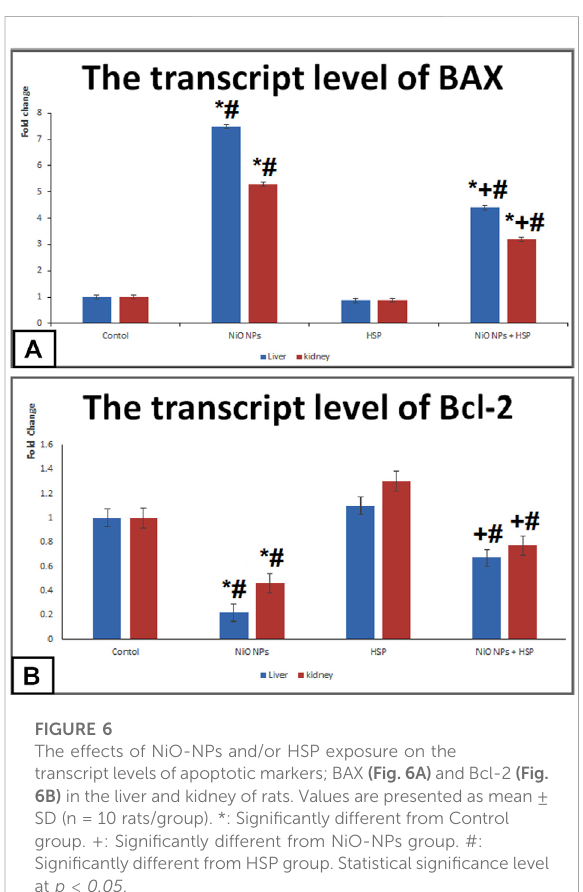
FIGURE 6 The effects of NiO-NPs and/or HSP exposure on the transcript levels of apoptotic markers;BAX (Fig. 6A) and Bcl-2 (Fig. 6B) in the liver and kidney of rats. Values are presented as mean ± SD (n = 10 rats/group). *: Signi fi cantly different from Control group. +: Signi fi cantly different from NiO-NPs group.